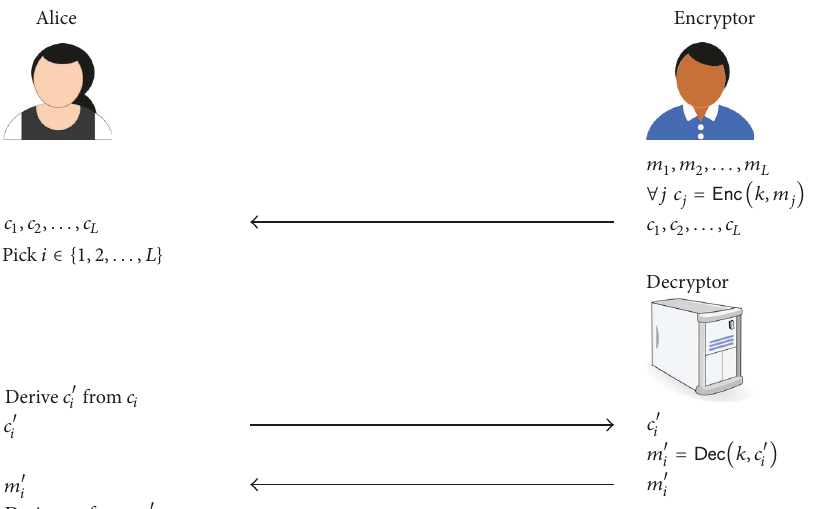
Figure 2: The general blind decryption scenario. Alice chooses a ciphertext 𝑐 𝑖 and derives a related ciphertext 𝑐 󸀠 𝑖 that she transmits to the decryptor. The decryptor responds with the corresponding plain-text message 𝑚 󸀠 𝑖 from which Alice can recover 𝑚 𝑖